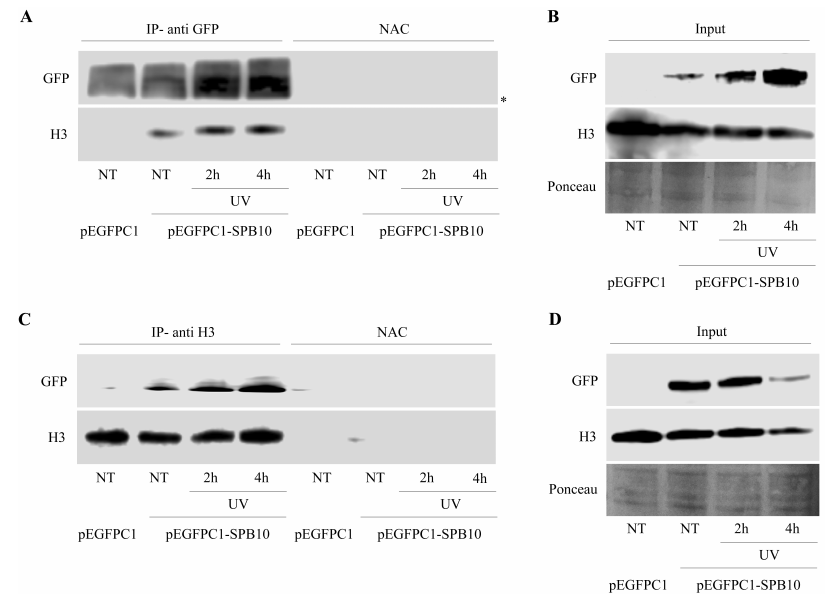
Figure 4. SPB10 shows interaction with H3: Immunoblot detection to reveal interaction between SPB10 and H3 in U2OS cells. Efficiency of immunoprecipitation experiment was controlled with ( A ) anti-GFP antibody (since cells were transfected with plasmid encoding SPB10-GFP fusion protein) and ( C ) anti-H3 antibody in precipitated samples in both control and UV-treated (2 and 4 h) samples. Asterisk shows unspecific bands. Western blots were performed on input protein samples to verify equal protein amount of each sample used for ( B ) SPB10-GFP and ( D ) H3 immunoprecipitation. Ponceau staining was used to detect equal